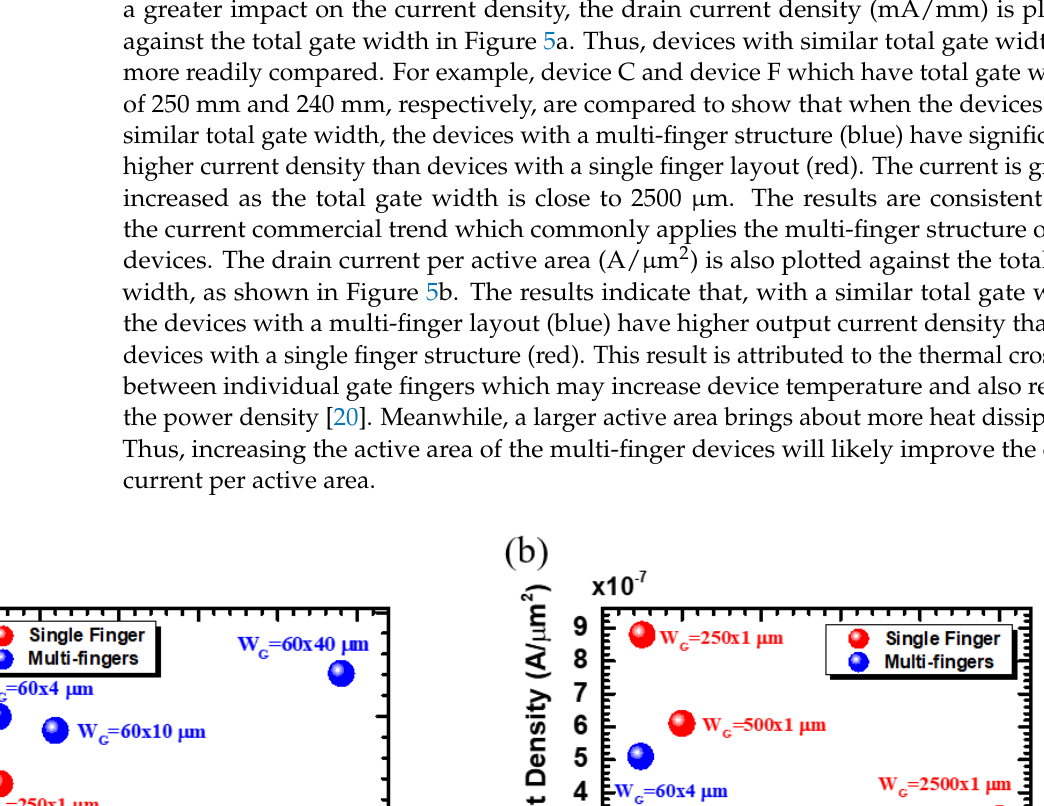
Figure 6. Device performance of the large-area p-GaN HEMT with total gate width 60 mm (1000 mm × 60 fingers). ( a ) Total drain current versus gate voltage at V DS = 10 V in linear and log scale. ( b ) Output performance at V DS = 0–10 V and V GS = 0–8 V. The threshold voltage (V TH ) is 2.2 V (defined by I DS = 1 mA/mm), the subthreshold swing (SS) is 221.1 mV/dec, and the on/off ratio is 1.4 × 10 5 which exhibits good switching characteristics. The output drain current and current density is 6.7 A and 112.5 mA/mm, respectively, at V GS = 8 V and V DS = 10 V, and the on-resistance (R on ) is 43.6 Ω -mm at V GS = 8 V. 4. Conclusions In this work, a high current normally-off p-GaN HEMT device with multi-finger lay- out was successfully fabricated using a self-terminating etching technique with Cl 2 /BCl 3 /SF 6 -mixed gas plasma. Several devices with different gate width and number of